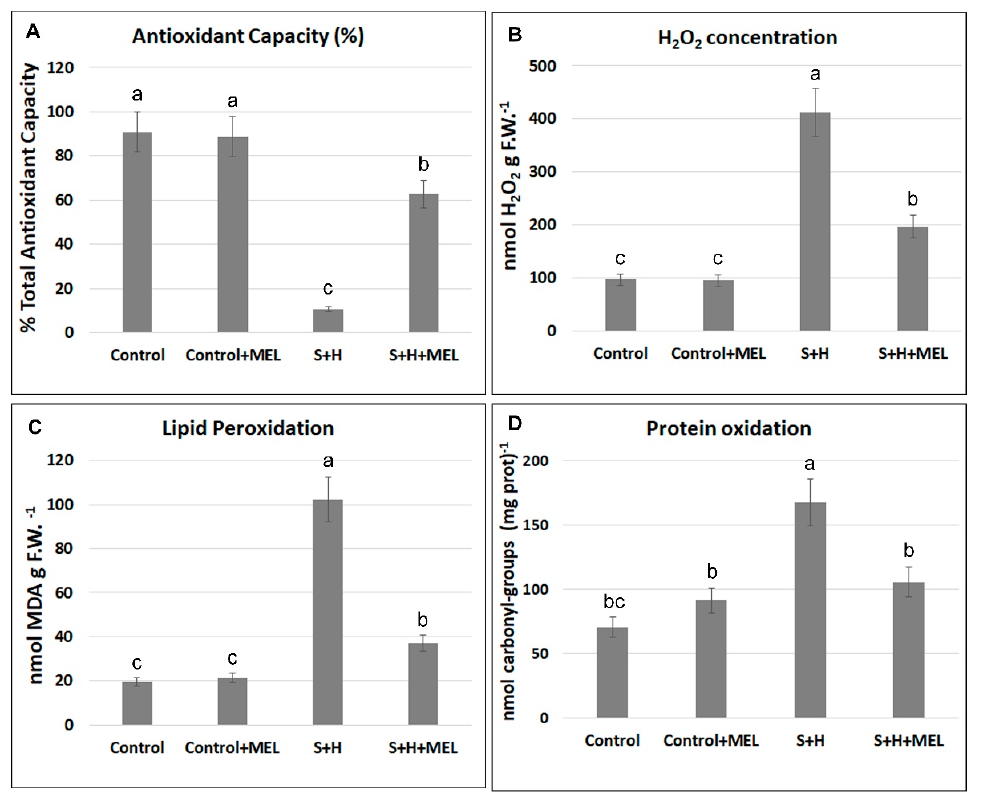
Figure 5. Oxidative stress in tomato leaves grown under control or stress combination conditions (salinity + heat, S + H) with (+MEL) or without melatonin pre-treatment. ( A ) Antioxidant capacity; ( B ) Hydrogen peroxide (H 2 O 2 ) concentration; ( C ) Lipid peroxidation measured as malondialdehyde (MDA) content; ( D ) Protein oxidation measured as carbonyl-groups content and normalized against soluble protein content. Values represent means ± SE ( n = 6). Bars with different letters within each panel are significantly different at p < 0.05 according to Tukey’s test.